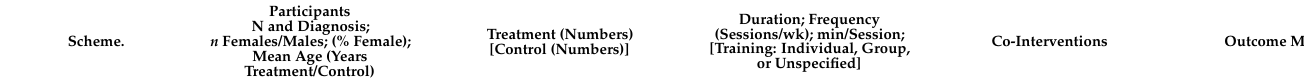
Treatment(Numbers) [Control(Numbers)] Co-Interventions